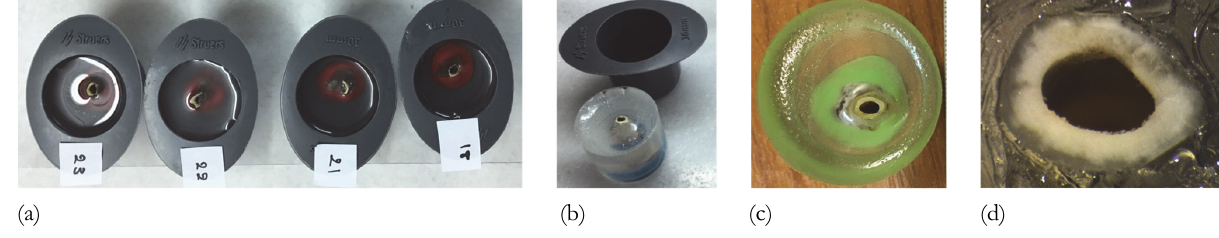
Figure 3: (a) The fractured bones surrounded by the resin in the plastic caps; (b,c) Typical bone-resin construct; (d) Photo of the polished surface of a typical